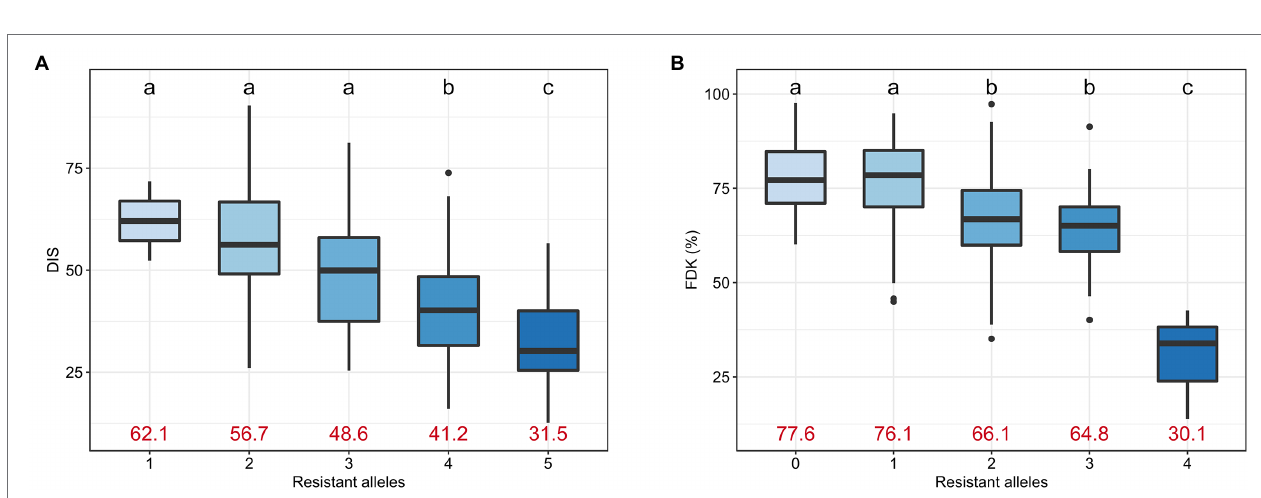
FIGURE 5 | Boxplots comparing the trait performance of the hard winter wheat lines carrying different numbers of resistant alleles for (A) DIS and (B) FDK, compared using an FDR-adjusted Least Significance Difference (LSD) test. Different letters on top of the boxplots denote statistically different groups. The mean trait value for DIS and FDK for the corresponding group is given using red